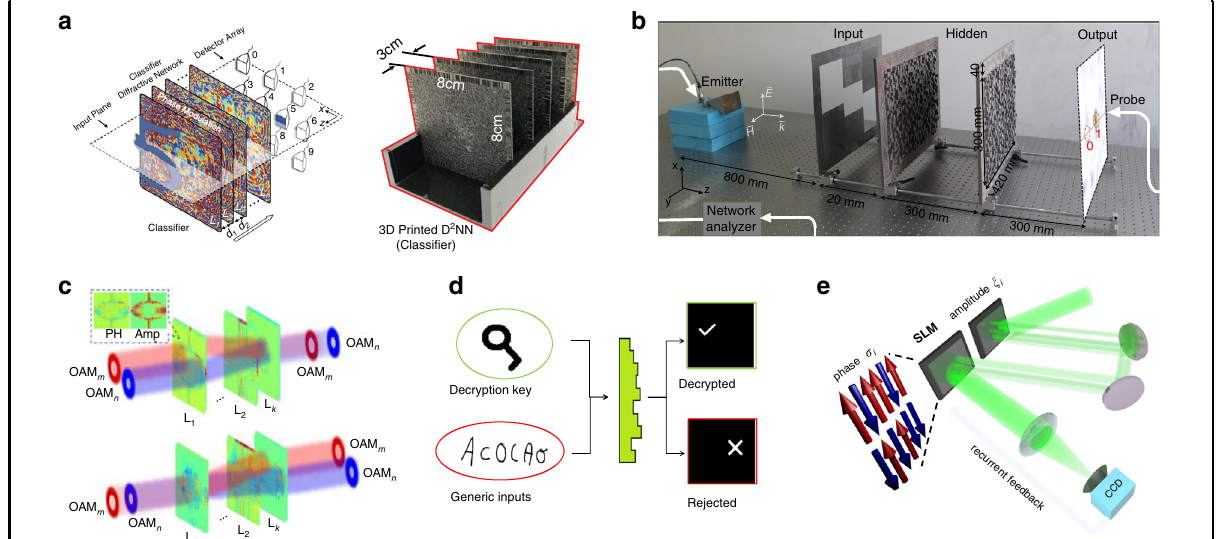
Fig. 8 MPLC-MVMs for ONNs. a Classi fi cation of images of handwritten digits and fashion products 46 . b Optical logic operations 54 . c OAM multiplexing and demultiplexing 50 . d Optical linear perceptrons 56 . e Photonic Ising machine 51,123 . a Reprinted by permission from AAAS 46 . b Reproduced from ref. 54 with permission of Springer Nature: Light: Science & Applications. c Reprinted from ref. 50 with the permission of IEEE Publishing. d Reproduced from ref. 56 with permission of Springer Nature: Light: Science & Applications. e Reproduced from ref. 123 . with permission of De Gruyter